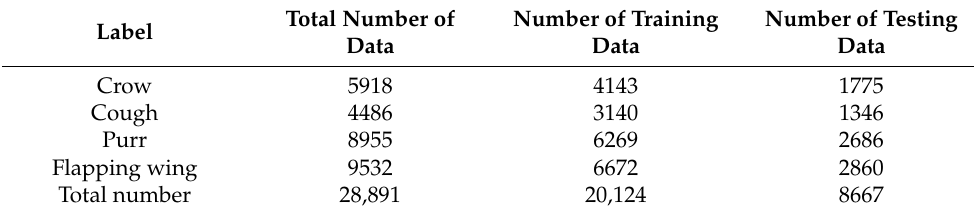
Table 2. Specific description of the preliminary data set.